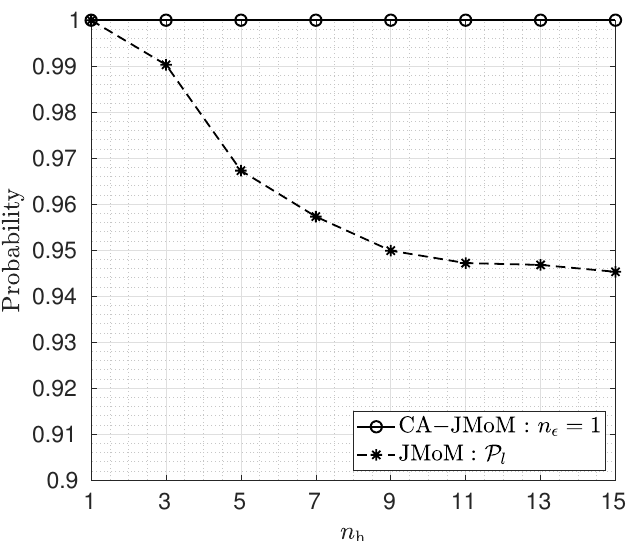
Figure 2. Lock-in probability for different values of number of channel taps when n z = 10. The performance of the proposed TO estimators for different number of observation OFDM symbols is shown in Figure 3. As the number of observation symbols increases, the lock-in probability of the JMoM and the SMC estimators increases. However, the lock-in probability of the CA-JMoM and the CA-SMC estimators cannot reach lock-in probability of one. Hence, while the JMoM and the CA-JMoM are consistent estimators, their CA versions are inconsistent. As seen, the performance of the CA versions of the estimators does not change with N because perfect parity check is considered.